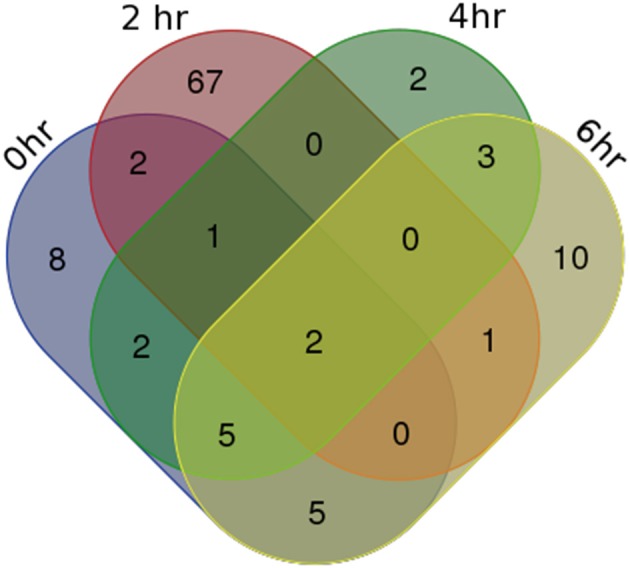
Venn Diagram of differentially expressed lncRNA transcripts in CF vs. non-CF cells at each time point of infection.